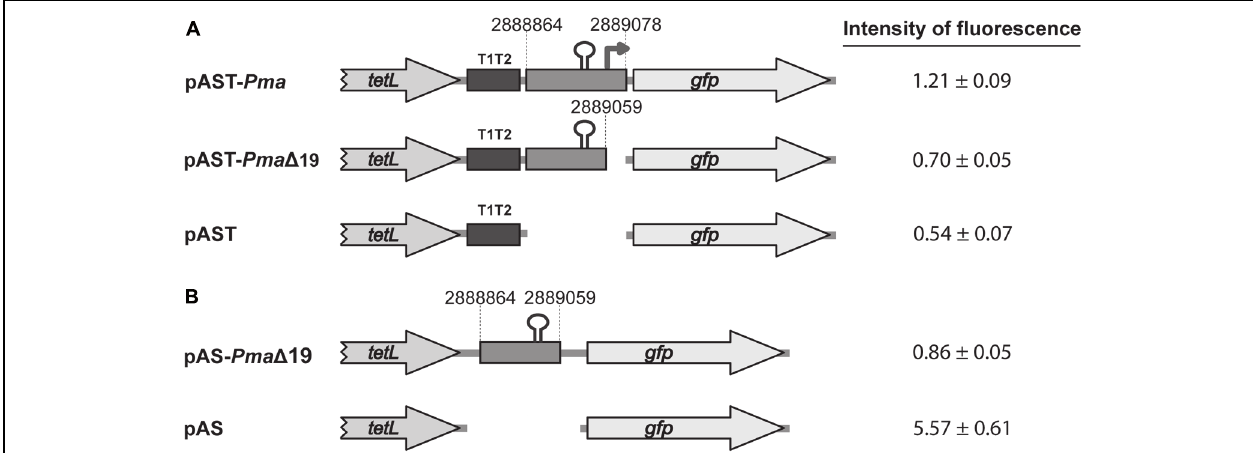
FIGURE 3 | Fluorescence assays. (A) Activity of the Pma promoter. The promoter-probe vector pAST was described (Ruiz-Cruz et al., 2010). Genes tetL (tetracycline resistance determinant) and gfp (green fluorescent protein) are indicated. The T1T2 box represents the tandem terminators T1 and T2 of the Escherichia coli rrnB rRNA operon. The coordinates of the V583 DNA regions are indicated. The stem-loop structure represents the inverted-repeat (IR) identified upstream of the Pma promoter (this work). (B) Role of the IR element. The terminator-probe vector pAS was described (Ruiz-Cruz et al., 2010). The intensity of fluorescence (arbitrary units) corresponds to 0.8 ml of culture (OD 650 = 0.3). In each case, three independent cultures were analyzed.